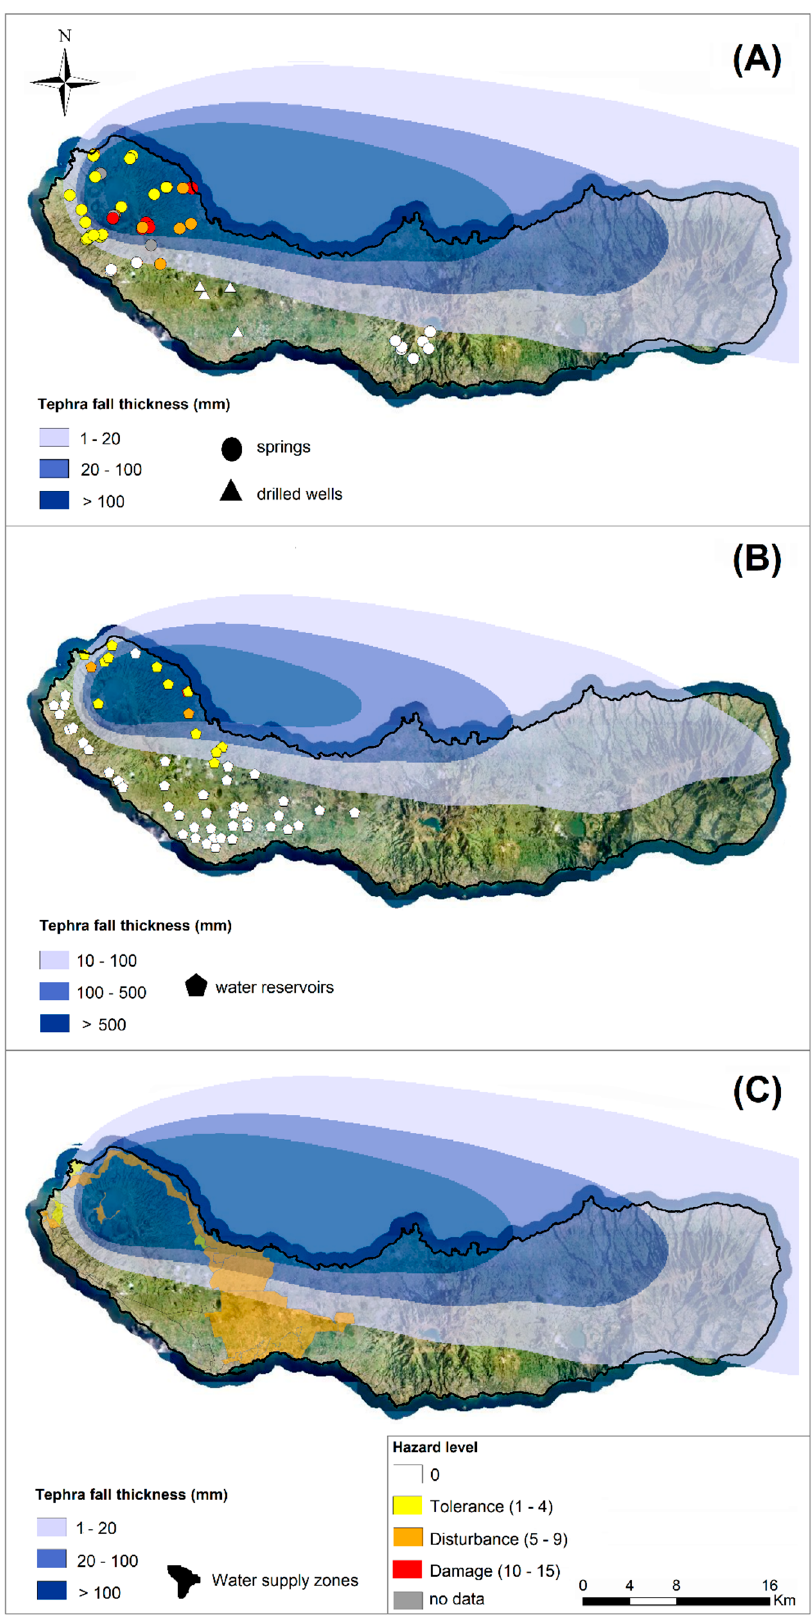
Figure 3. Cartographic representation of the impacts of eruptive scenario A, respectively, for: ( A ) Volume of water being abstracted; ( B ) storage capacity of the reservoirs; ( C ) number of inhabitants being served by the system over the water supply system of Ponta